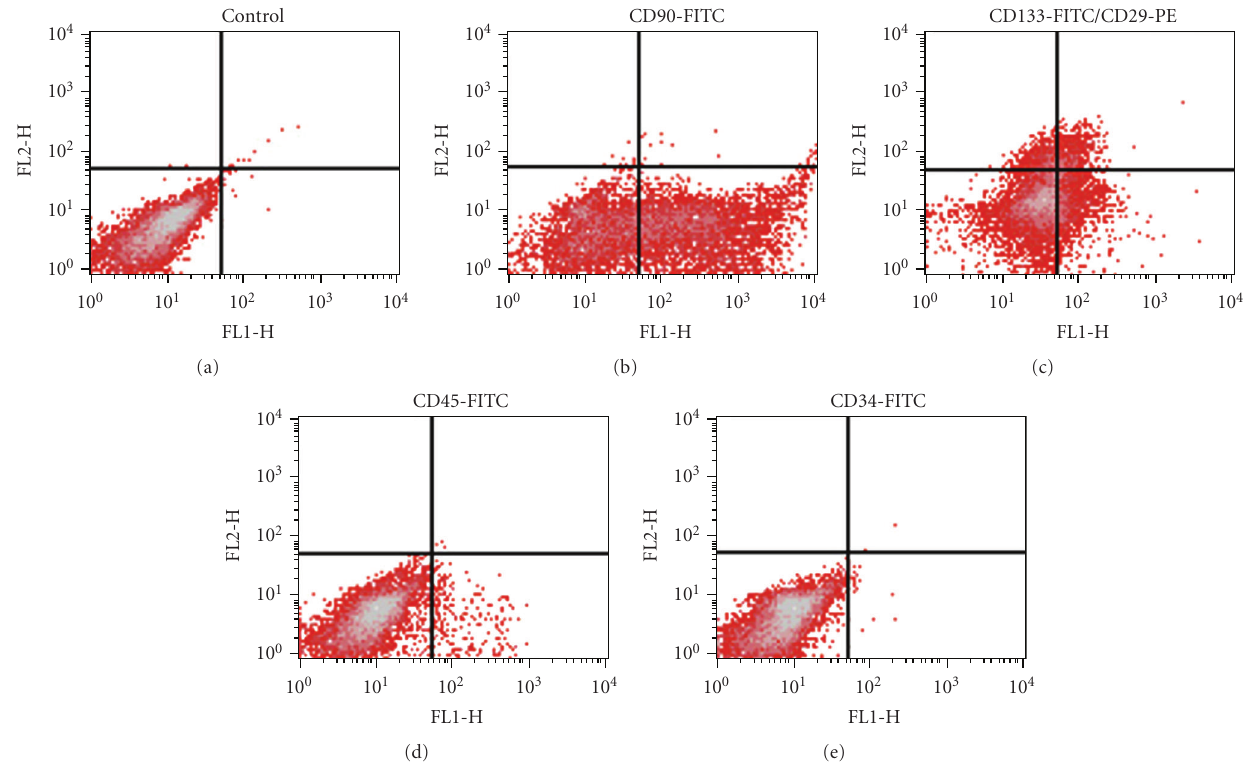
Figure 2: Representative images of flow cytometry analyses for rat brown adipose-derived cells. Brown adipose-derived cells are partly positive for CD-29, CD90, and CD133, while negative for CD45 and CD34. (a) Control; (b) Flow cytometry analysis for surface marker CD90; (c) Flow cytometry analysis for surface marker CD29 and CD133; (d) Flow cytometry analysis for surface marker CD45; (e) Flow cytometry analysis for surface marker